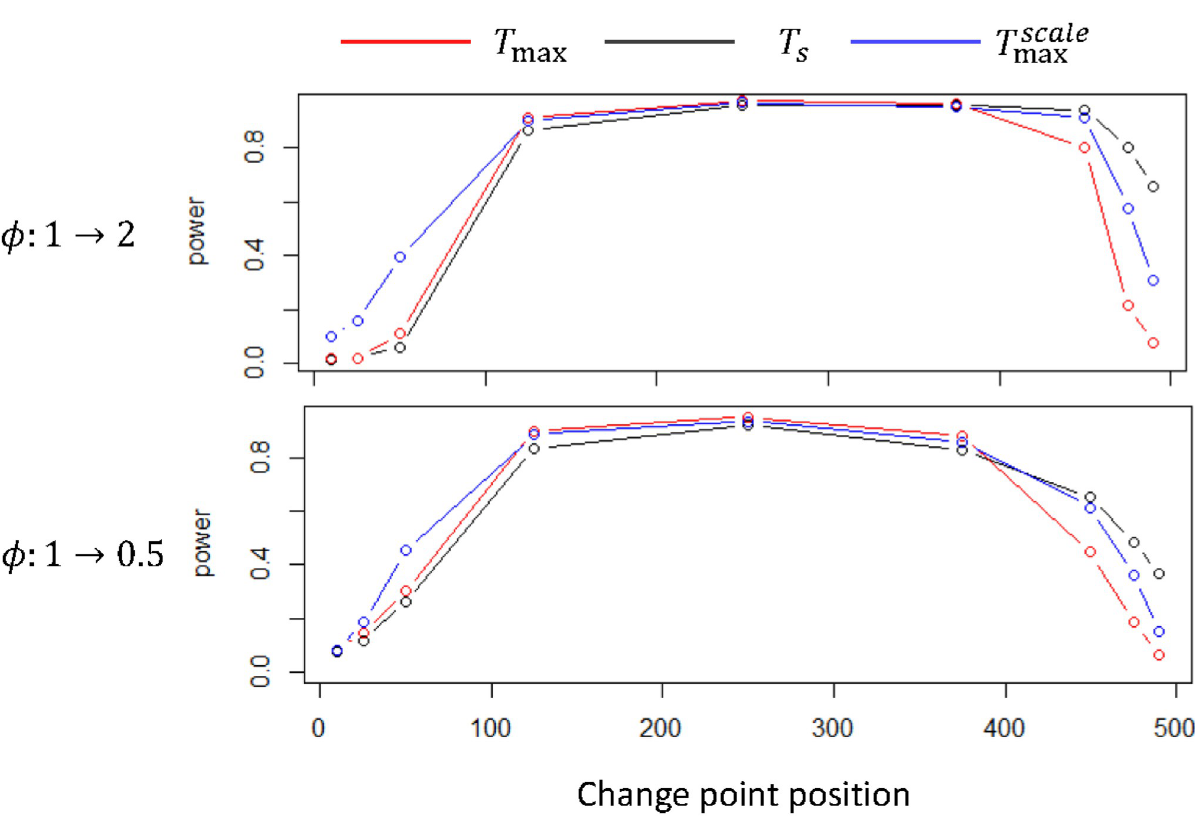
Fig 10. Powers in Lorenz